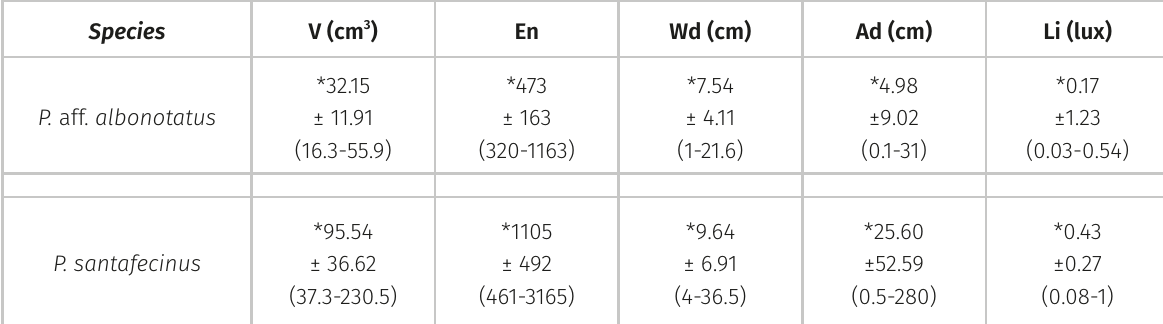
Table III. Foam nests and microhabitats of nest site characterization of P. aff. albonotatus and P. santafecinus . Average values (*), standard deviation (±), and minimum and maximum values ( ) of the following variables are included: nest volume (V), egg number (Eg), water depth (Wd), anchorage distance (Ad), and light incidence (Li). Species V (cm 3 ) En Wd (cm) Ad (cm) Li